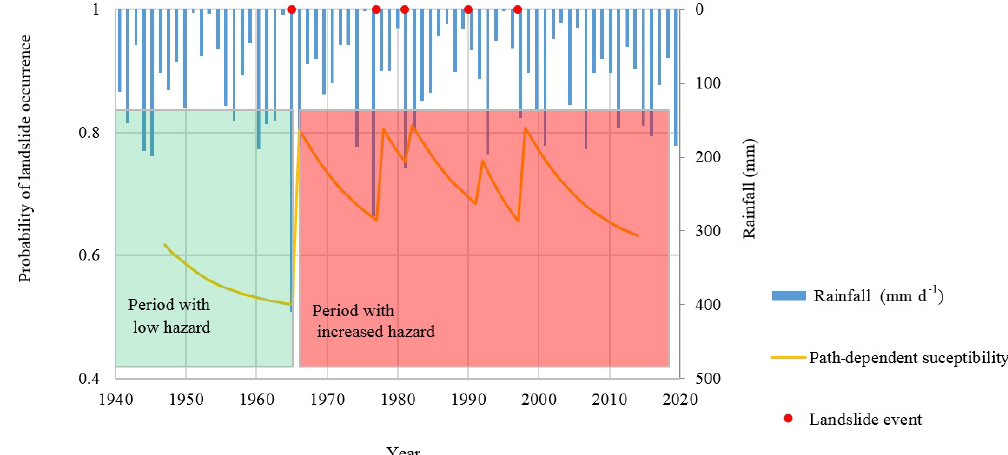
Figure 11. Conceptual model of the implication of dynamic path-dependent landslide susceptibility model in landslide hazard assessment. When susceptibility is low, the hazard is also low (providing the other components of landslide hazard, e.g., size, remain unchanged) and large rainfall events are needed to trigger new landslides. Then, when susceptibility is raised by such landslides, the hazard is also high and small rainfall events may trigger new